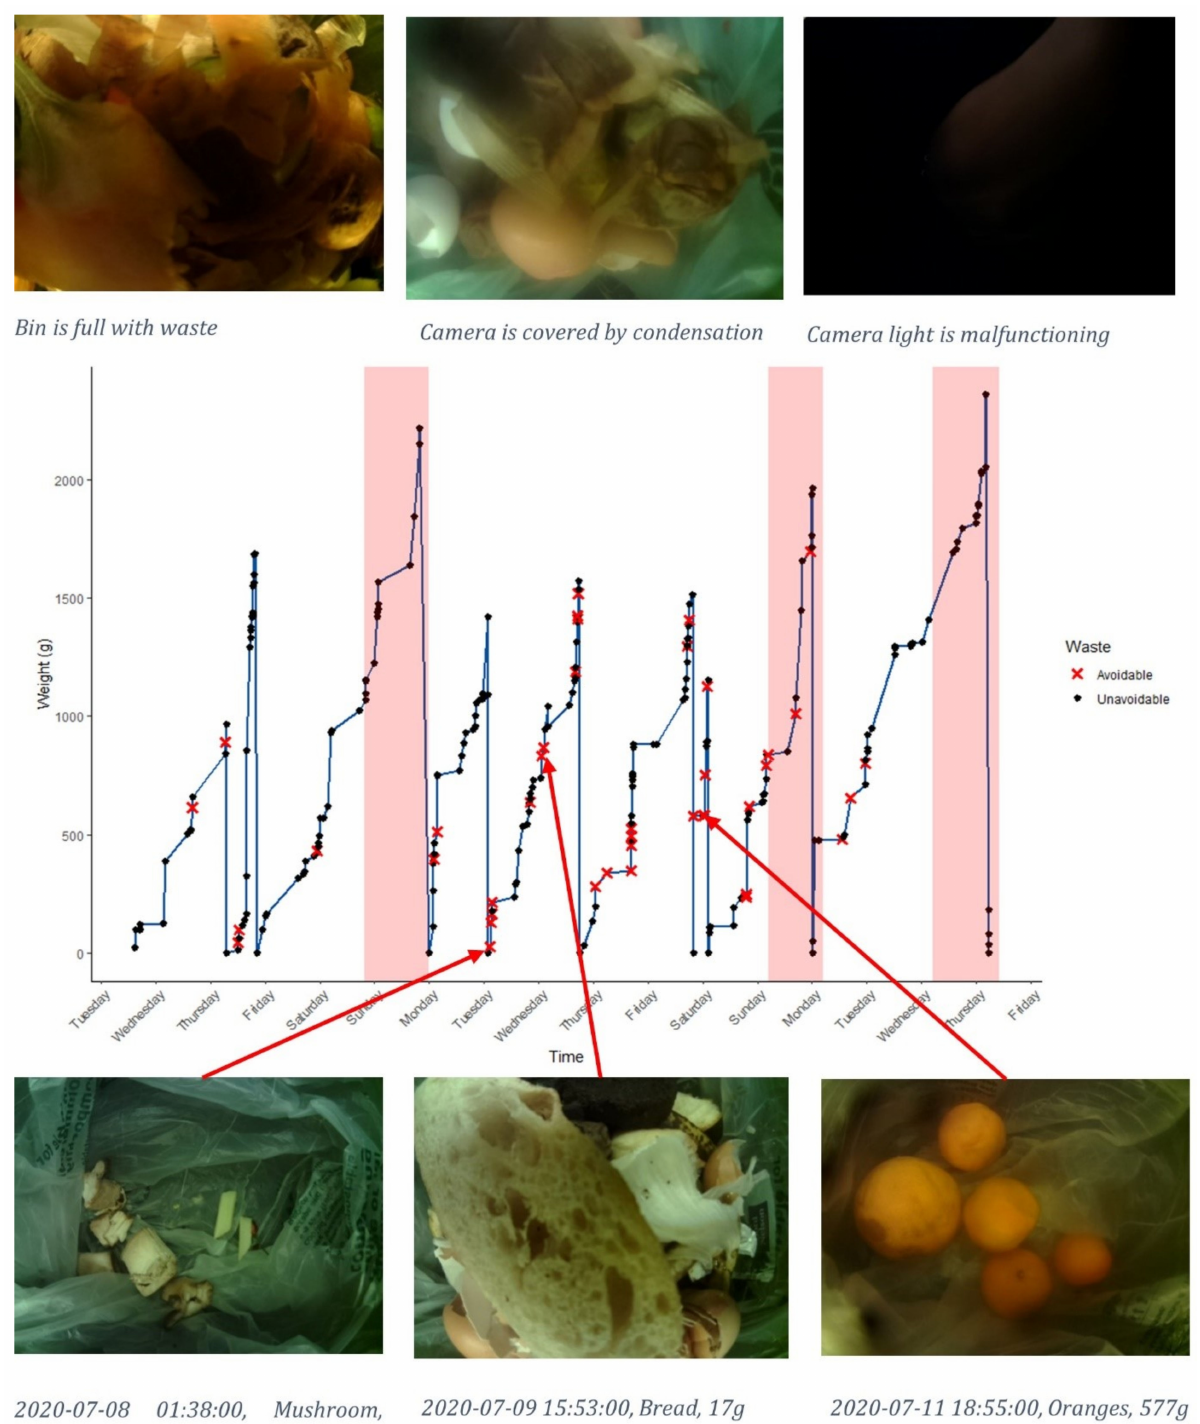
Figure 3. Household 3’s weight of food waste over time and photographic